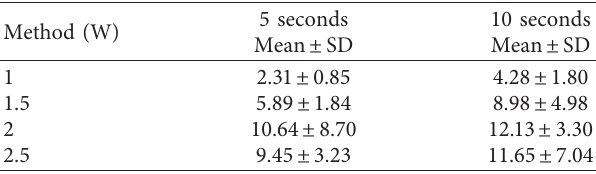
Table 4: SBS (mean ± SD) of different laser etching methods according to time.